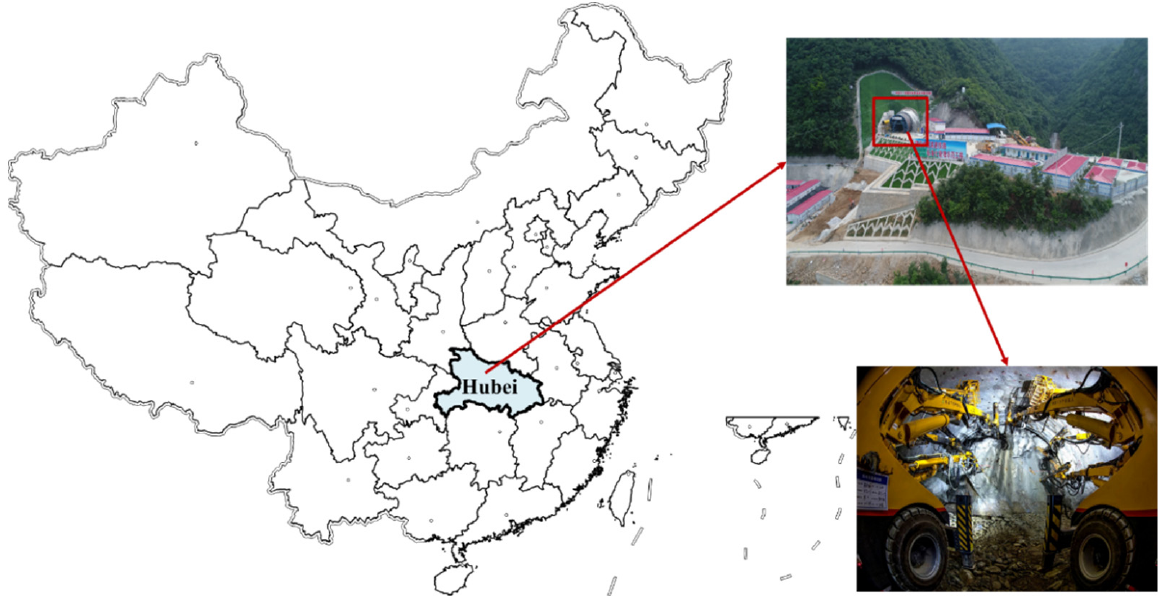
Figure 12. Interface of the position of the Gaojiaping Tunnel of the Zhengzhou–Wanzhou high- speed railway.